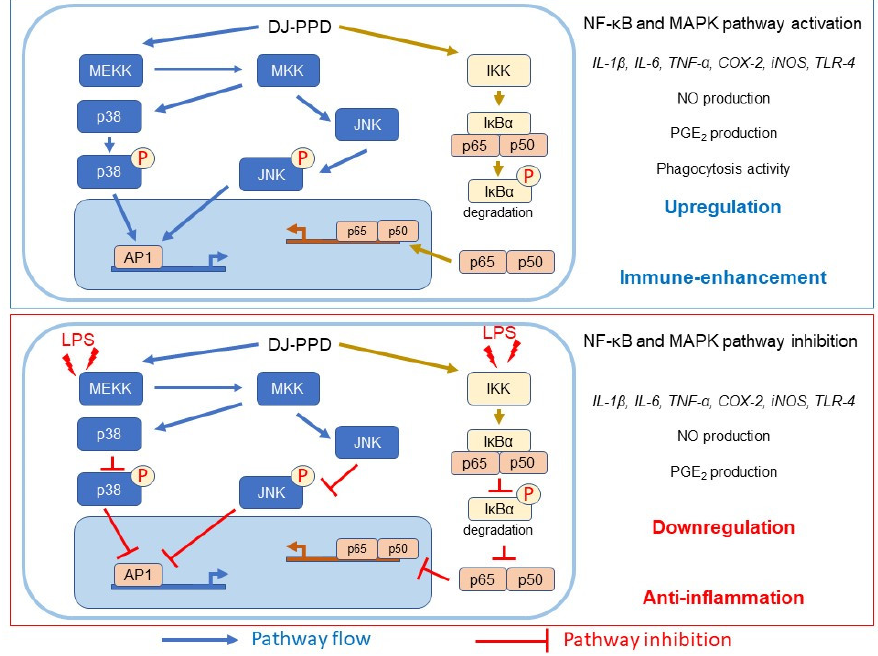
Figure 8. Schematic diagram of the effects of DJ-PPD on NF-κB and MAPK pathway regulation. Supplementary Materials: The following supporting information can be downloaded at: www.mdpi.com/xxx/s1, Figure S1: Protopanaxadiol chemical structure; Figure S2: The calibration curve of PPD over the concentration range of 0.0156–0.50000 ppm; Figure S3: PPD analysis using LC-MS in DJ and DJ-PPD